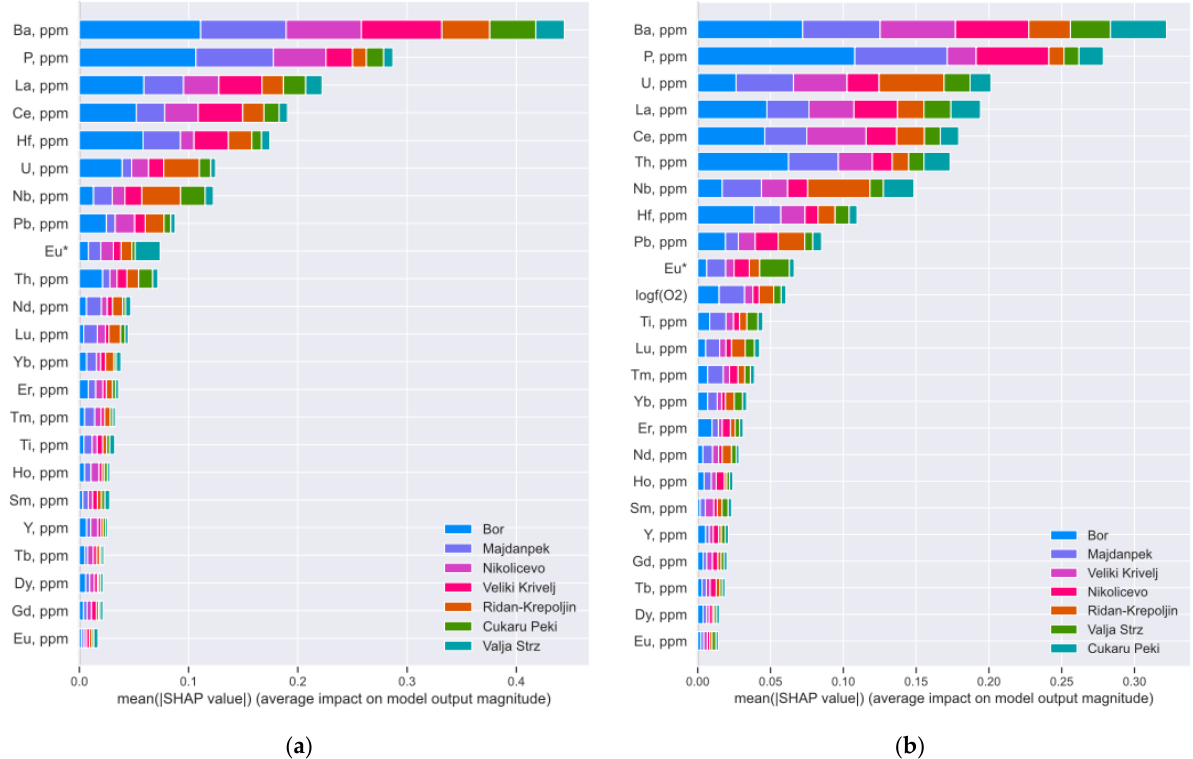
Figure 19. SHAP plot of relative feature importance for the training set, showing relative importance of each input variable for the random forest classifier, using trace elements and Eu anomaly as input variables ( a ), and adding calculated log fO2 ( b ).